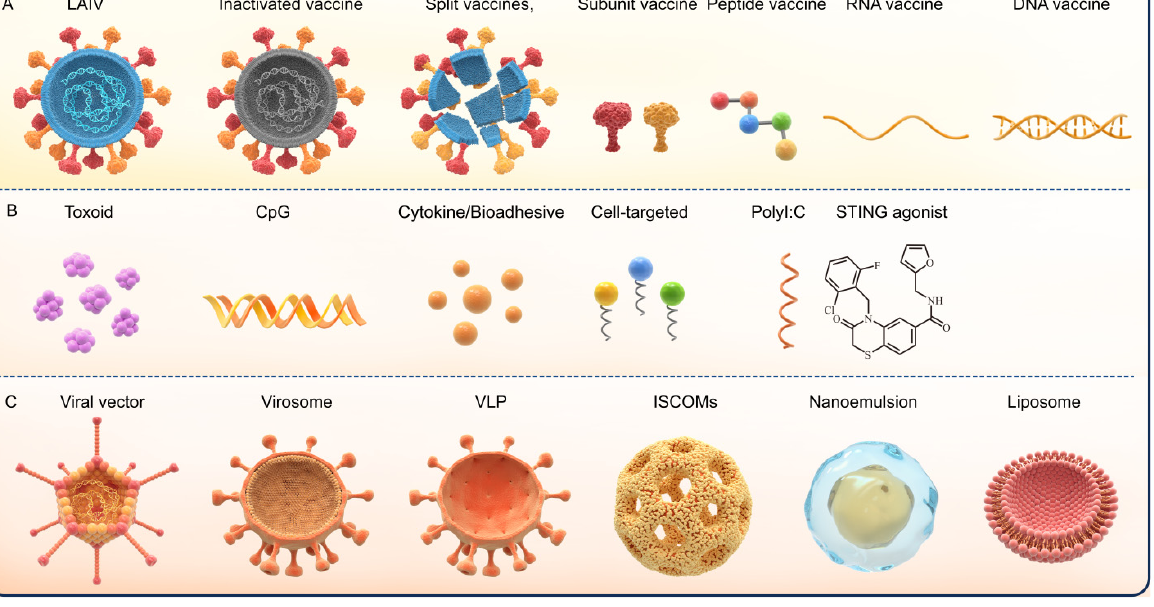
Figure 2. The different types of nasal vaccines and adjuvants. ( A ) The subtypes of nasal vaccines. ( B ) The subtypes of immune enhancement adjuvants. ( C ) Adjuvant delivery system. ( B ) The subtypes of immune enhancement adjuvants. ( C ) Adjuvant delivery